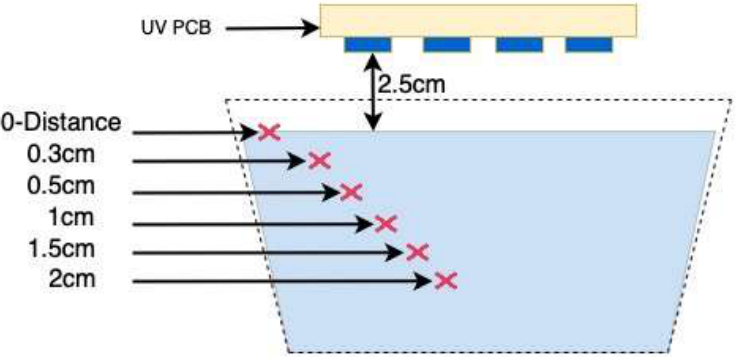
Figure 2. Measuring the UV light transmission losses from the LEDs under the water at different depths.